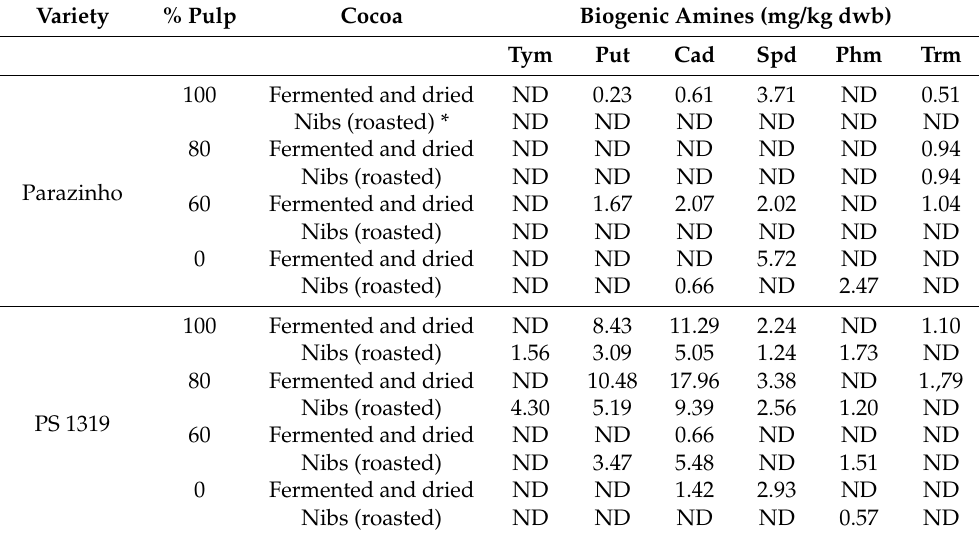
Table 1. Levels of free bioactive amines in fermented and dried cocoa and in the nibs (roasted cocoa beans) of two varieties of cocoa (PS 1319 and Parazinho) from Bahia, Brazil, using different proportions of pulp (100, 80, 60, and